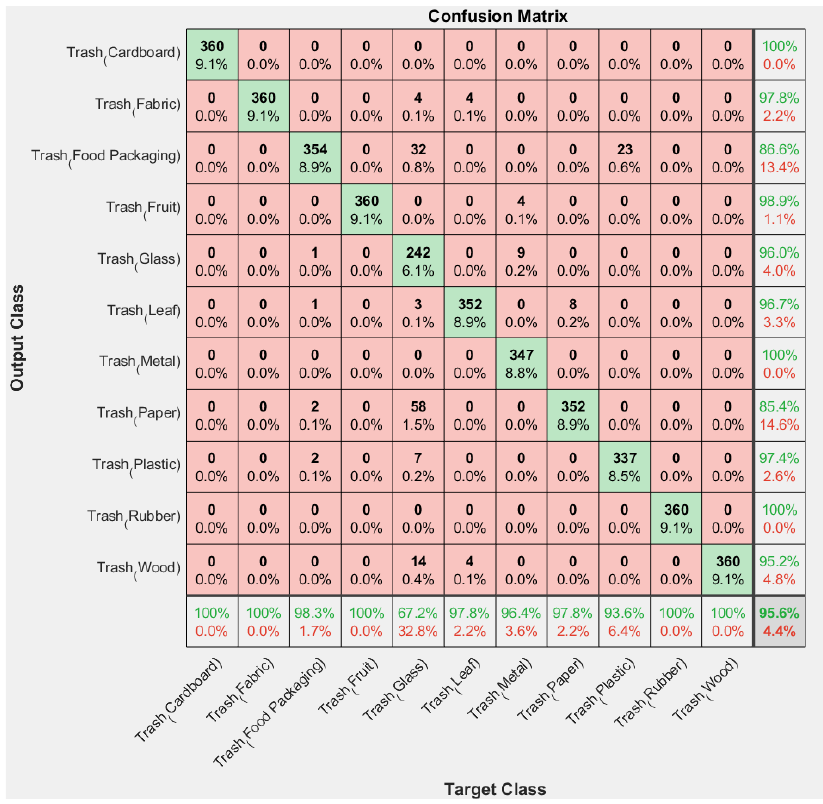
Table 4. Training Progress Result.